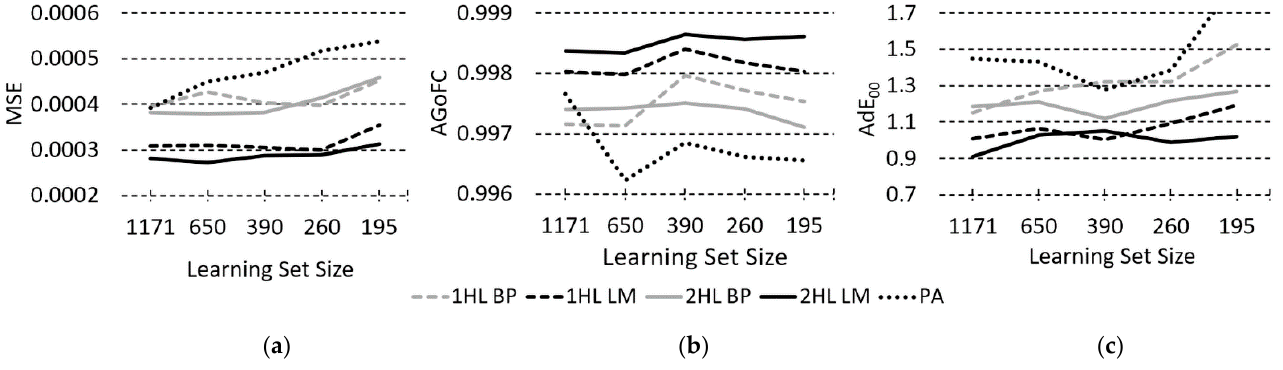
Figure 6. Examples of an in-number-of-cameras average best test set performances: ( a ) MSE for two cameras, ( b ) AGoFC for one camera, and ( c ) A ∆ E* 00 (D50 illuminant) for three cameras, all according to the learning set size.